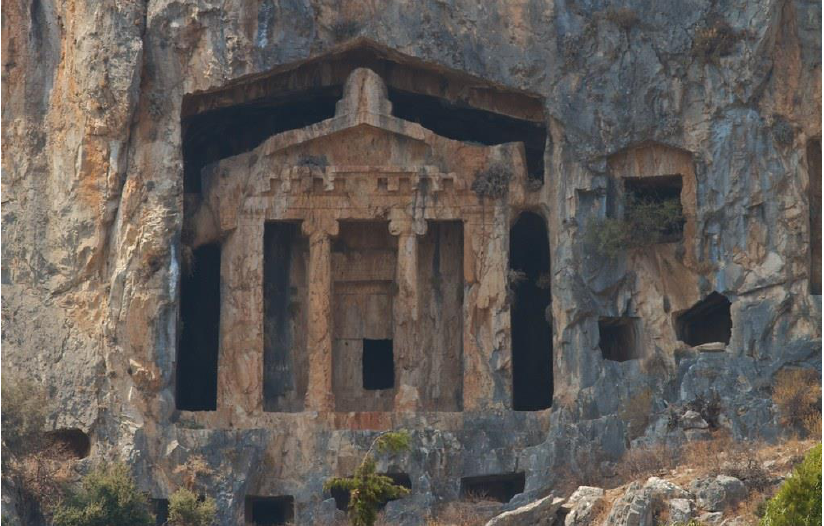
Figure 3. Temple Tomb. (“Dalyan Lycian Rock Tombs” by Peter J Dean is licensed under CC BY-NC-ND 2.0).